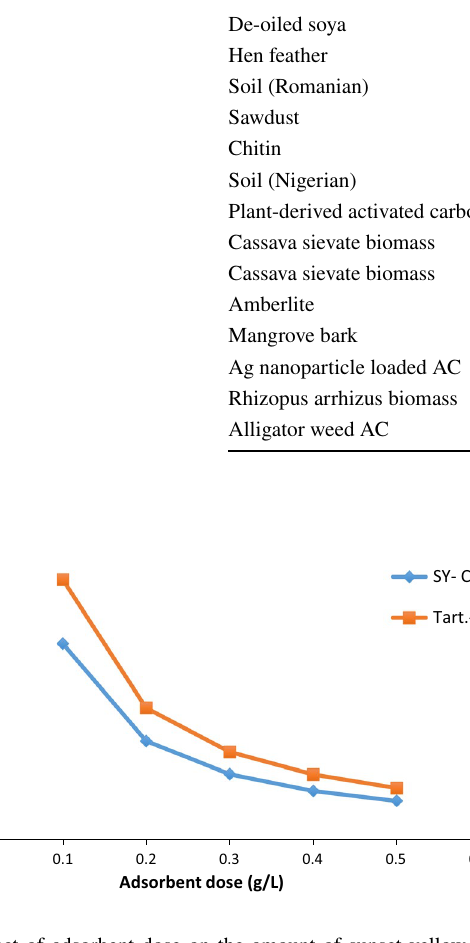
Table 2 Comparison of the uptake capacity of CS for dyes with other reported materials